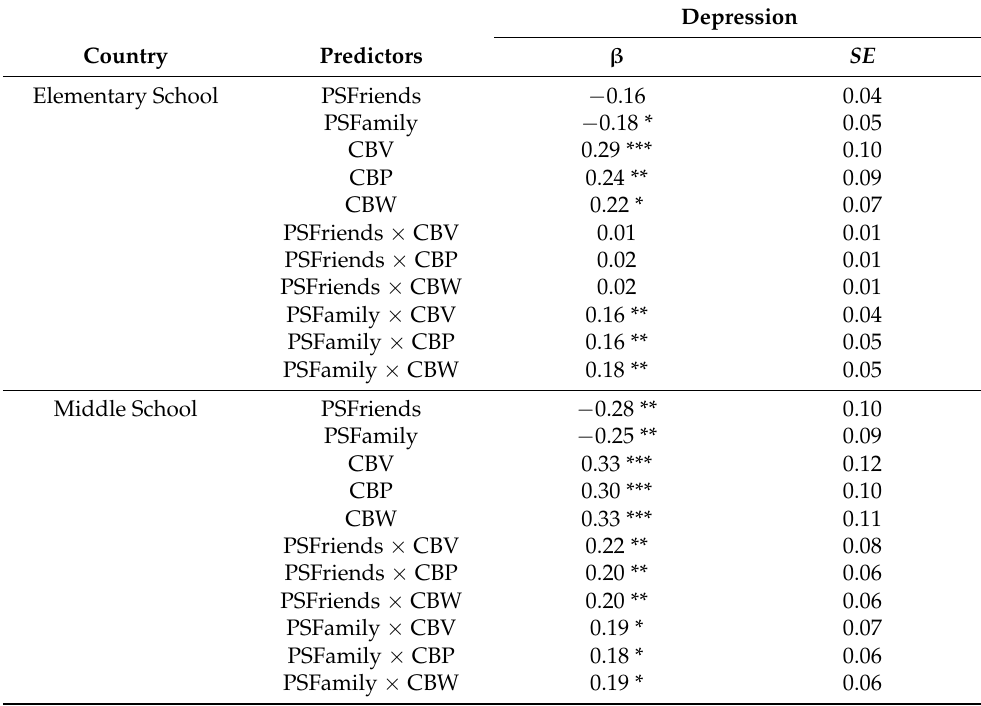
Table 3. Multigroup comparison of the associations among perceived social support, cyberbullying involvement, and depression by age